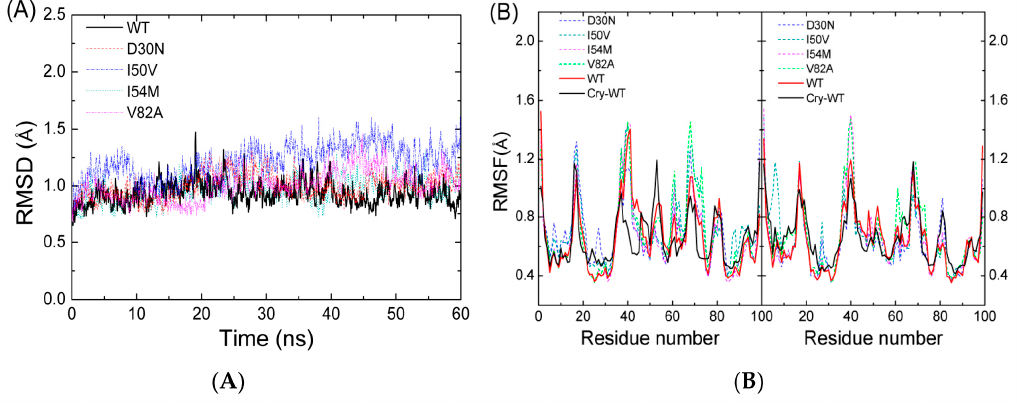
Figure 2. Cont. Figure 2.